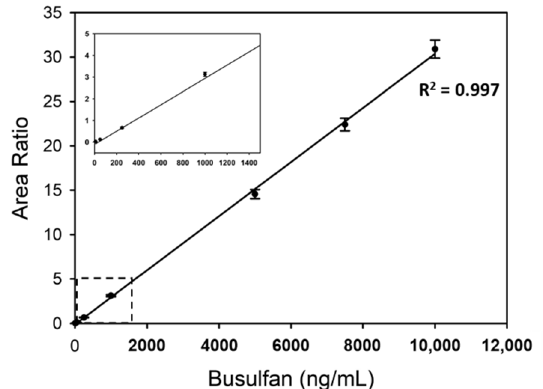
Figure 2. Linearity of busulfan analysis using newborn calf serum with 10, 50, 250, 1000, 5000, 7500, and 10,000 ng/mL busulfan. For each concentration, mean values from 10 repeated results were plotted. The region of the dashed-line box was enlarged in a small plot. The coefficients of determination R 2 of the trend line have been also presented.